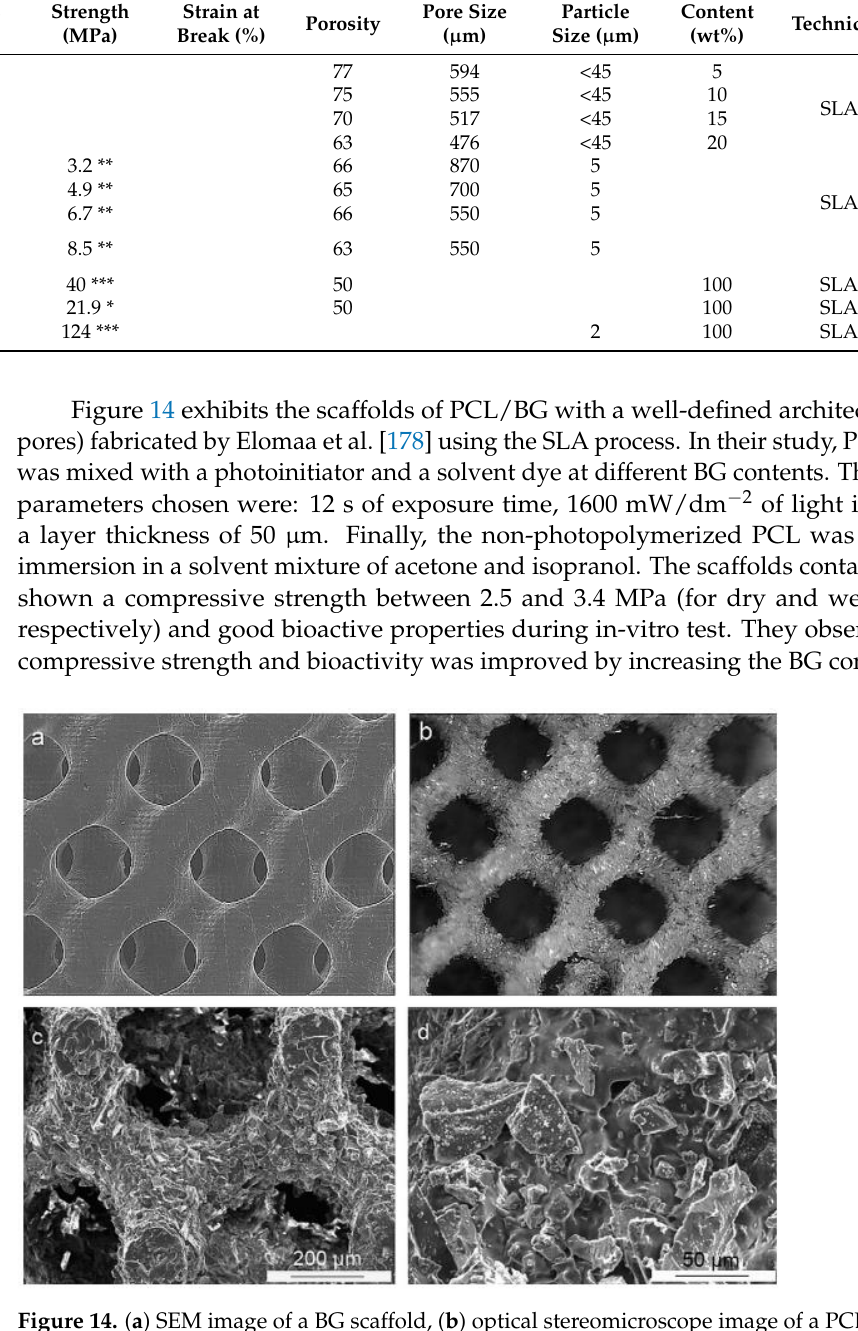
Figure 14. ( a ) SEM image of a BG scaffold, ( b ) optical stereomicroscope image of a PCL scaffold with 20 wt% of BG and ( c , d ) SEM images of a surface of a PCL/BG scaffold. Reproduced from [178]. Tesavibul et al. [182] shown for the first time the 45S5 BG scaffold fabrication with 3D interconnected pores by lithography-based AM process. After the green part fabrica- tion, the solvent and the polymeric blinder were eliminated and the sample sintered. Thavornyutikarn et al. [179] fabricated different scaffold architectures to show the struc- ture with the most controllable properties such as the compressive strength, the pore in- terconnection and shrinkage. In this investigation, different pore shapes and pore sizes with the same level of porosity were studied. The combination of an optimum scaffold structure and a thermal pre-treatment of BG powders exhibited mechanical properties close to those of cancellous bone. They used an acrylate-based photopolymer resin as a sacrificial agent mixed with BG (41 vol%). After the 3D printing, the scaffolds were heated at 550 °C during 3 h to burn out the resin. Ma et al. [181] optimized the debriding and sintering parameters of 45S5-BG scaffolds fabricated by SLA with a photosensitive resin. The optimized parameters were a sintering temperature at 1000 °C, heating rate of 5 °C/min and a holding time of 0h. Gmeiner et al. [183] increased up to 124 MPa the bending strength of dense 3D printed BG fabricated by SLA process. The slurries presented a high content (70 wt%) of well-dispersed BG particles. The FT-IR technique was used by Kang et al. [180] to verify the completely non-pres- ence of blinders after the sintering step. They fabricated scaffolds of 45S5 bioactive glass with photocurable and acrylate blinders. The objective was to obtain dense structures from polymeric suspension with high BG particles loading. However, a high concentra- tion of BG particles increased the viscosity of the suspension, hindering the printability. Analyzing the rheological behavior of the suspensions, the authors calculated the printa- ble composition with the highest BG content. The scaffolds elaborated with the highest BG content (60% of blinder and 40% of BG) and with the highest viscosity, show the best mechanical and morphological properties: less shrinkage, a high relative density and high biaxial flexural strength.